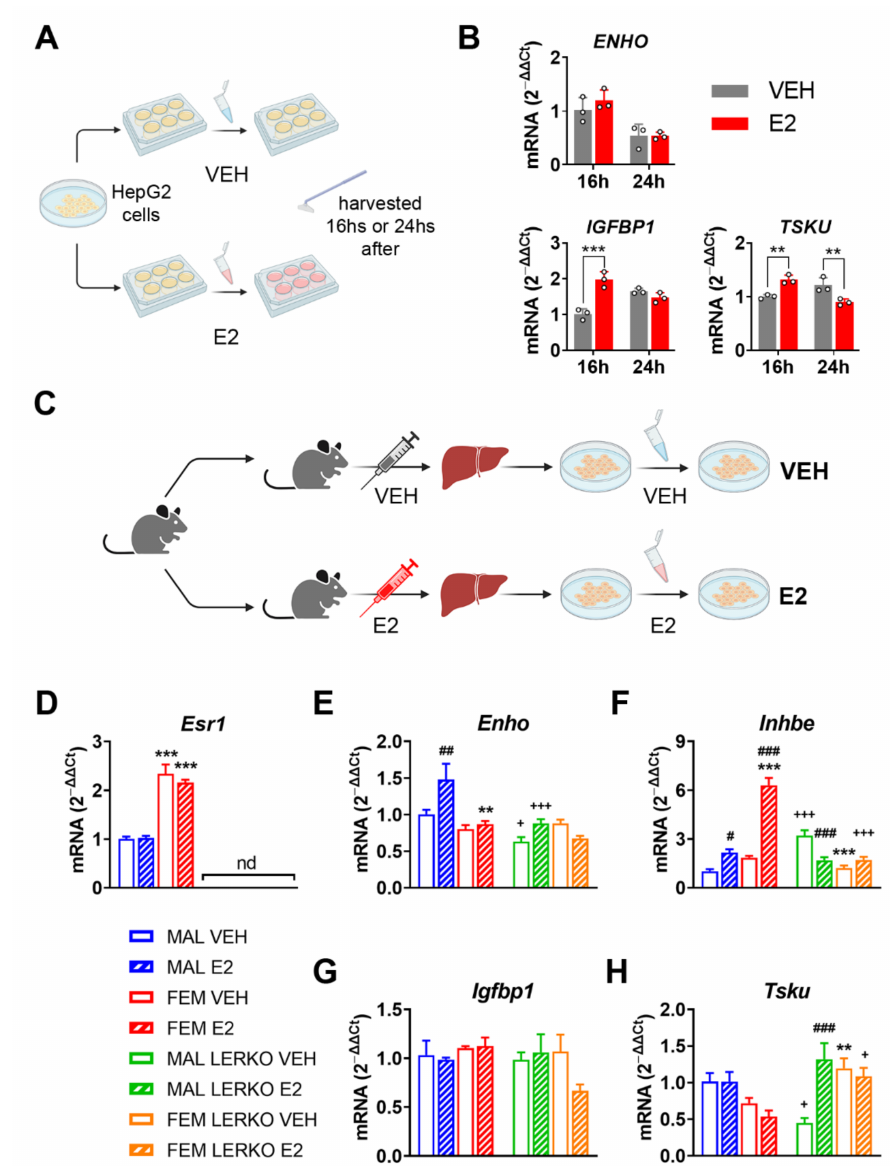
Figure 2. Estrogen modulates hepatokine mRNA levels in hepatic cells acting through ER α